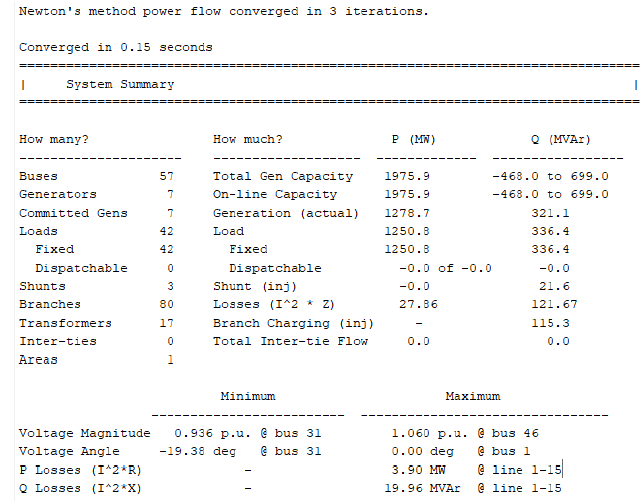
Figure 5. System summary and load flow analysis using Newton-Raphson method